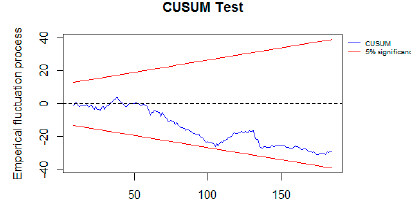
Figure 3. CUSUM test of kefir.